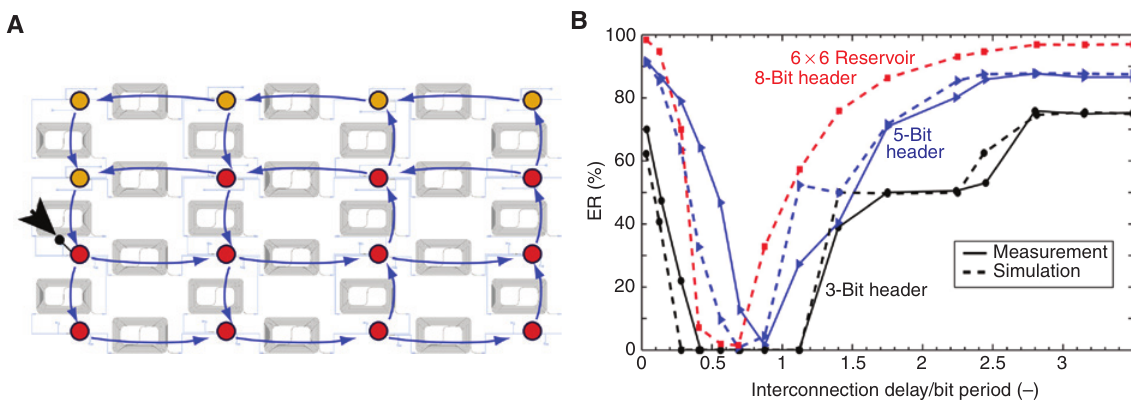
Figure 3: Reservoir implemented on a passive silicon chip [38]. (A) A linear optical network is implemented using optical waveguides, split- ters, and combiners. Blue arrows illustrate the implemented reservoir connectivity. (B) Experimental and numerical evaluation of optical header recognition via on-chip RC (figure courtesy of Peter